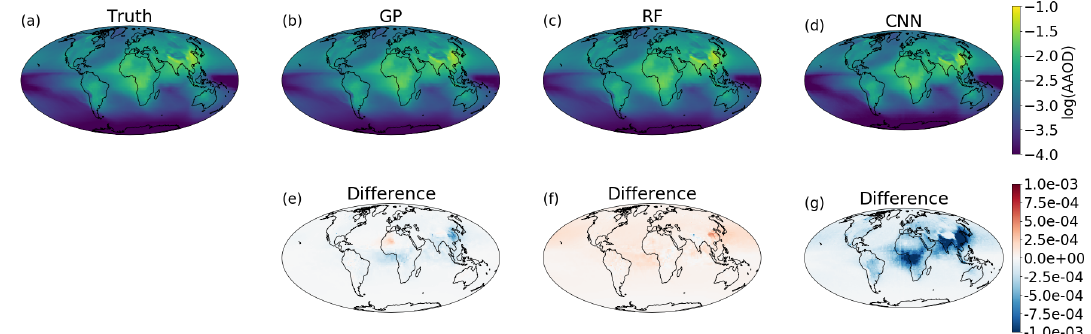
Figure 2. Example emulation of absorption aerosol optical depth (AAOD) for a given set of three model parameters (broadly scaling emissions of black carbon, removal of black carbon and the absorptivity of black carbon) as output by (a) the full ECHAM-HAM aerosol climate model, (b) a Gaussian process emulation, (c) a random forest emulation, and (d) a convolutional neural network emulator for parameter combinations that were not seen during training. The differences between ECHAM-HAM and the emulators are also shown (e–g)